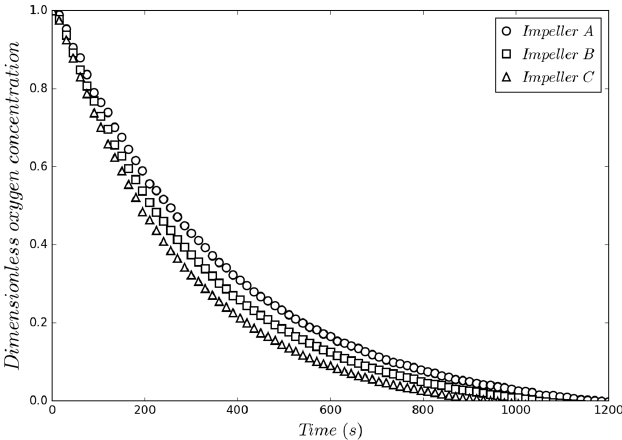
Figure 6. Deoxidation kinetics in a water model using the three impellers at 400 rpm and 10 L/min.